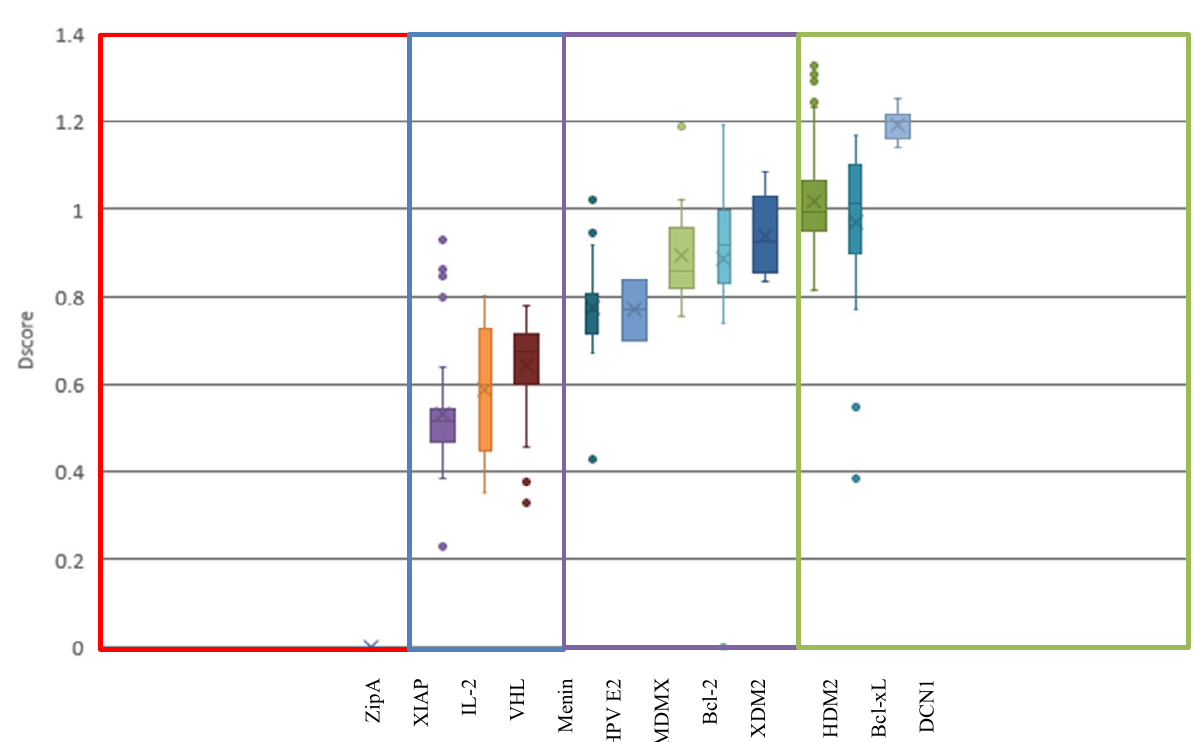
Figure 3. Box-plot showing range and distribution of druggability for each protein using the proposed classification system for PPIs, ranked by median Dscore. Dscore ≥ 1.0: very druggable (green box); Dscore ≥ 0.75 and < 1.0: druggable (purple); Dscore ≥ 0.5 and < 0.75: moderately druggable (blue); Dscore < 0.5: difficult (red). ZipA values were undefined and hence assigned a value of